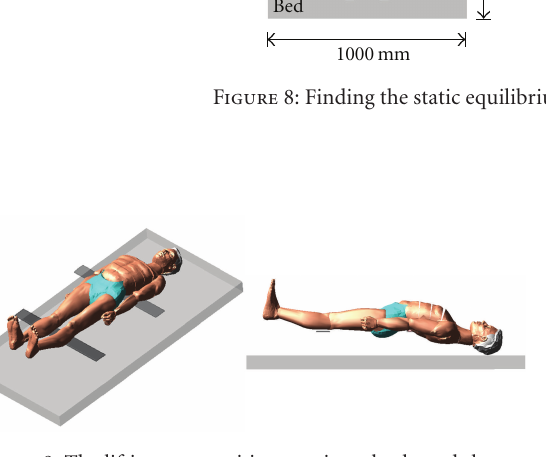
Figure 9: The lifting arm position causing a backwards lean.